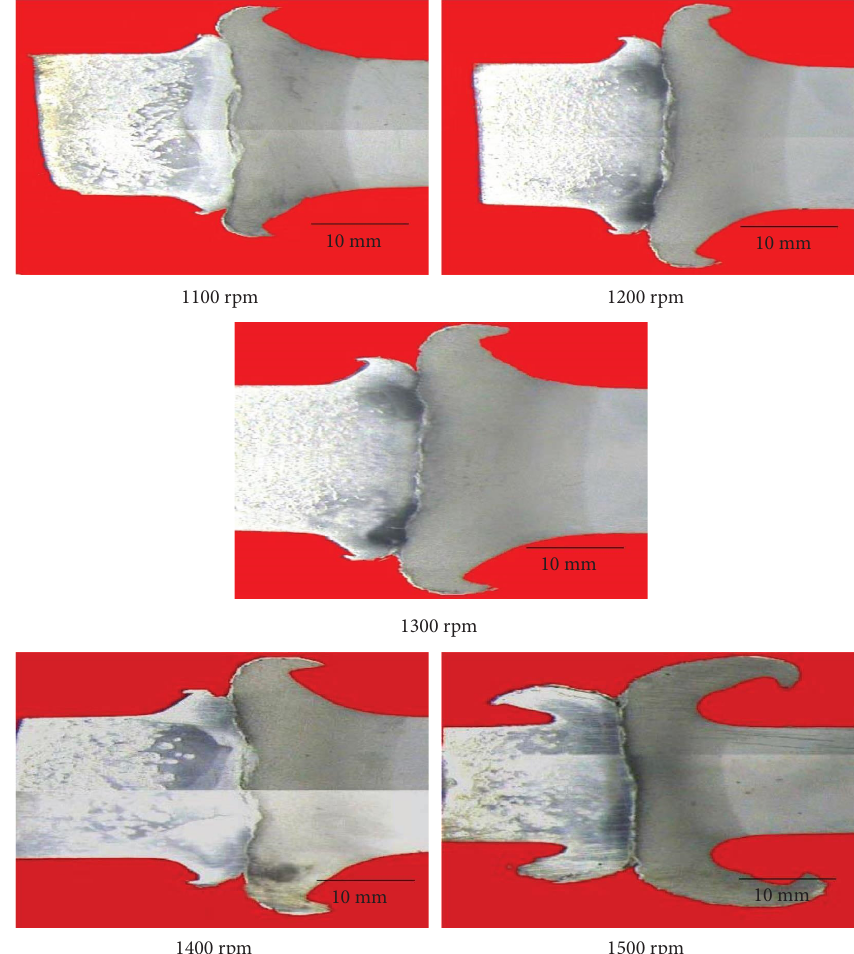
Figure 4: Macrostructure of dissimilar friction welded